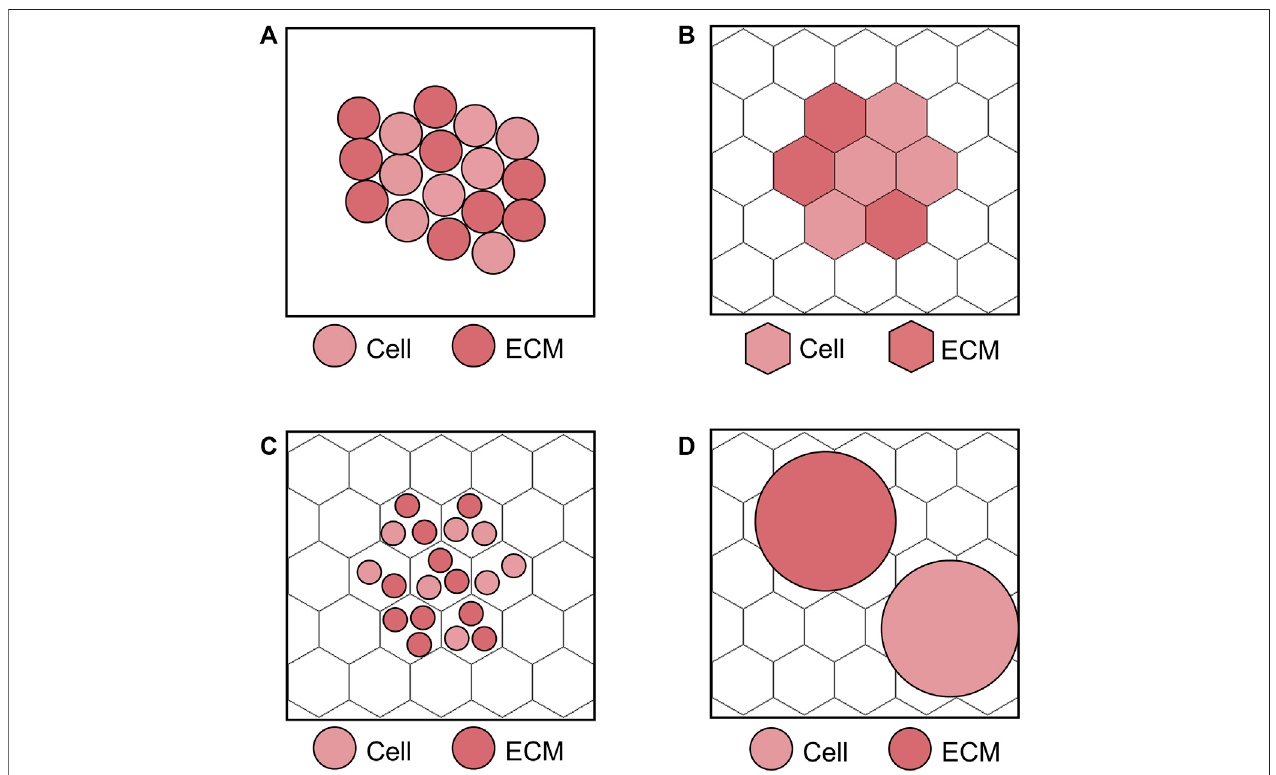
FIGURE3| Examples oflattice-freeandlattice-basedagent-based model(ABM)atthecellscale. (A) Lattice-freeABM. (B) Lattice-based ABMwithonelatticesite corresponding to a single agent, i.e., cell or extracellular matrix (ECM). (C) Lattice-based ABM with multiple agents (cells and ECM) at one lattice site. (D) Lattice-based ABMwithagents (cells and ECM) occupying more than onelattice site. The lattice-based ABMsshown in (B – D) areimplemented onahexagonallattice,asinCortiet al. (2020).